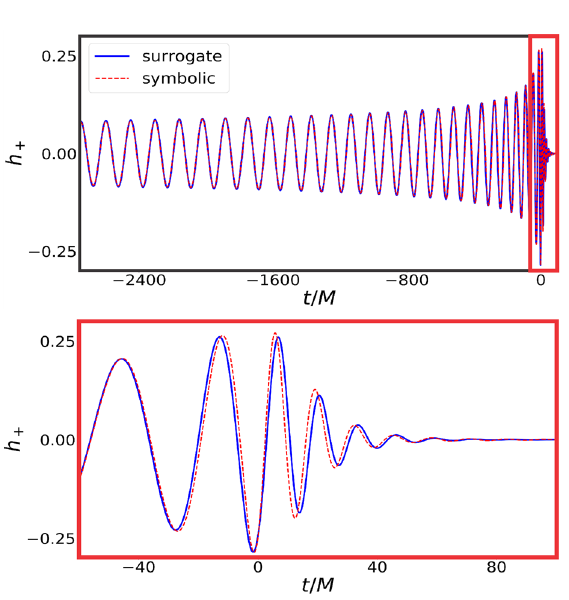
Figure 6. Symbolic and surrogate waveforms corresponding to the worst match in a posteriori validation with respect to the surrogate model. Top : the whole waveforms, with the vertical redline prior to merger, at t / M = − 60 . Bottom : zoom in of the waveforms in the range t / M ∈ [− 60, 100 ] . The differences near the merger are noticeable, but the overlap is still S = 0.9905